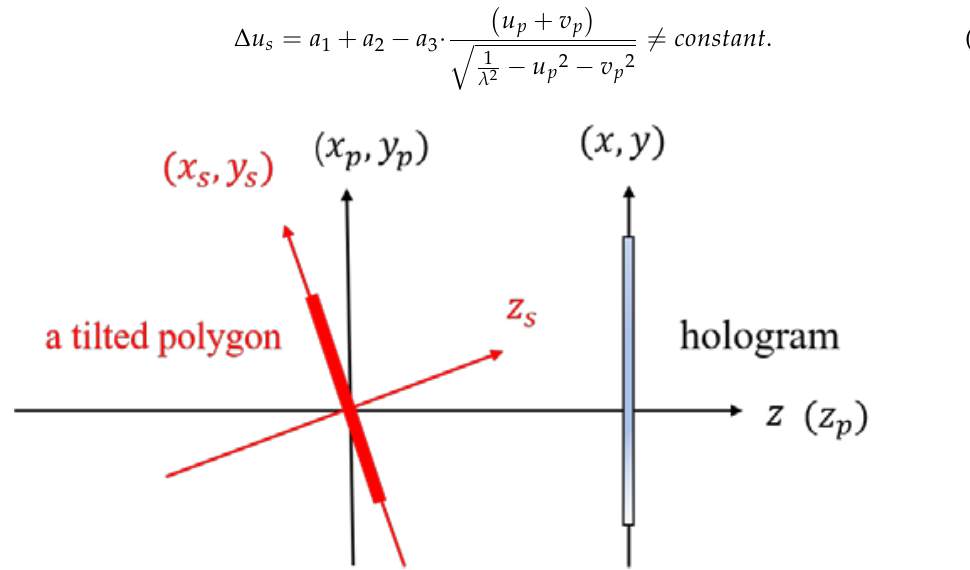
Figure 2. Coordinate systems of the traditional polygon-based method: source coordinate system ( x s , y s , z s ) , parallel local coordinate system (cid:0) x p , y p , z p (cid:1) and hologram plane ( x , y ) . Adapted from Zhang et al. [8].